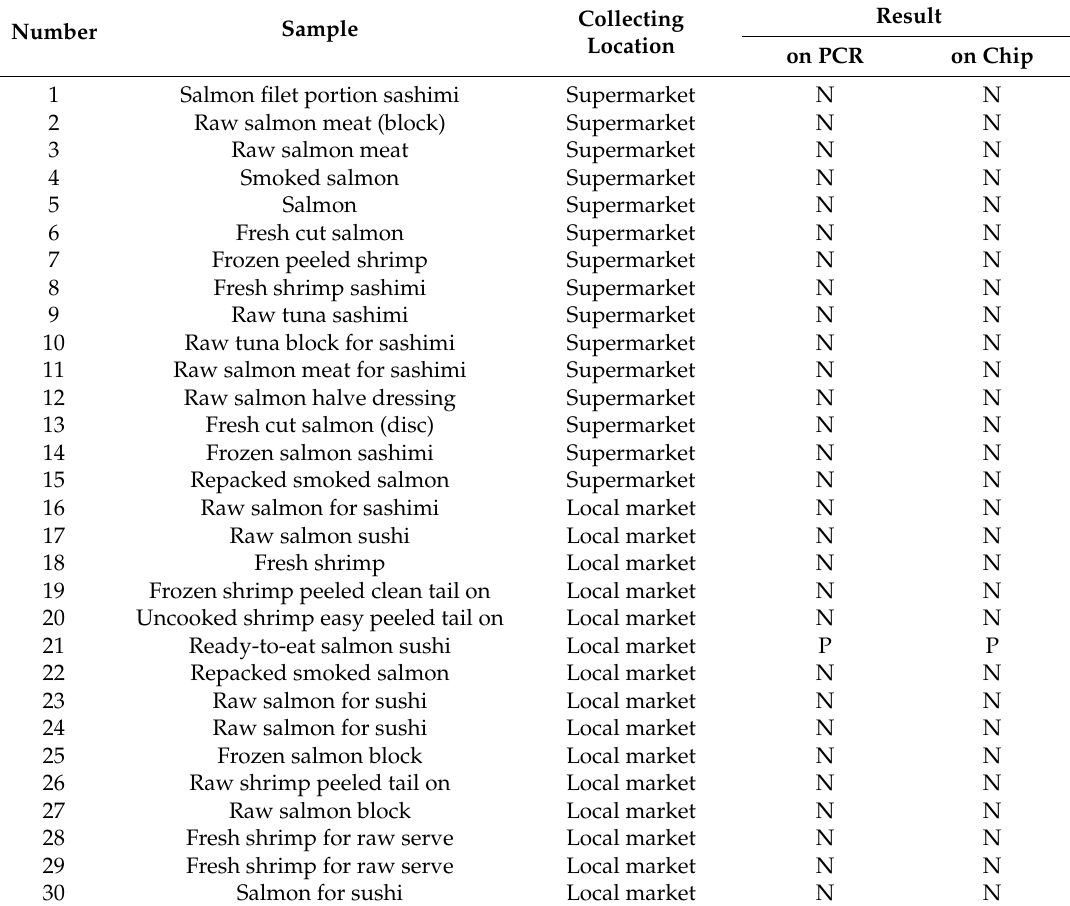
Table 4. On-site screening of products from modern supermarkets and